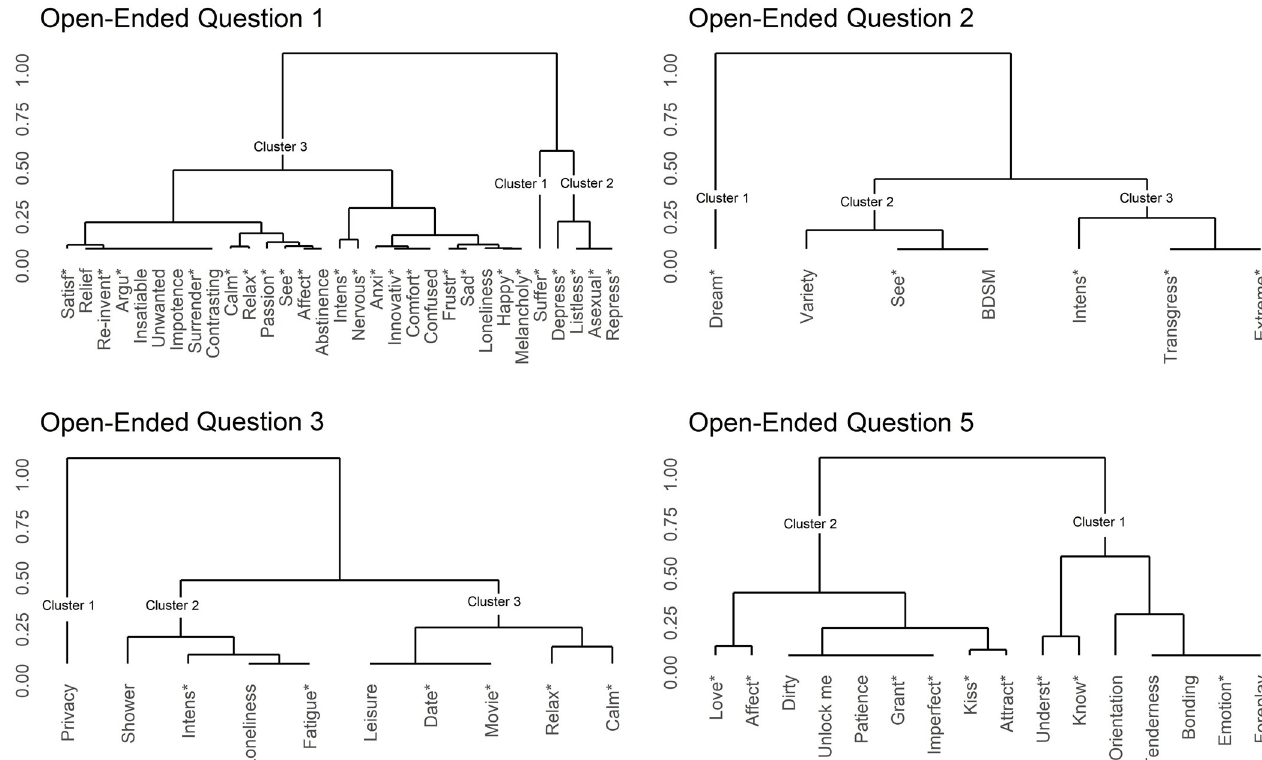
Fig 1. Cluster dendrograms of extracted terms (open-ended questions). Cluster dendrograms are based on the Euclidean Distances’ Matrix of the 64 Salient Stems for Open-Ended Question 1, 2, 3, and 5. A Hierarchical Cluster Analysis was performed to group similar terms in relation to their TF-IDF Index. Euclidean distances are reported on a modified scale with units from 0 to 1 (0 = maximum proximity/similarity; 1 = maximum distance/dissimilarity).